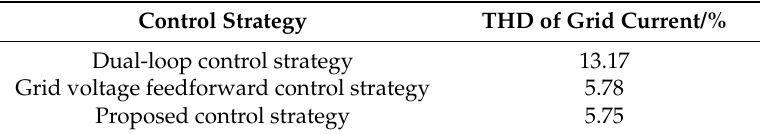
Table 2. THD of grid current under different harmonic suppression schemes.